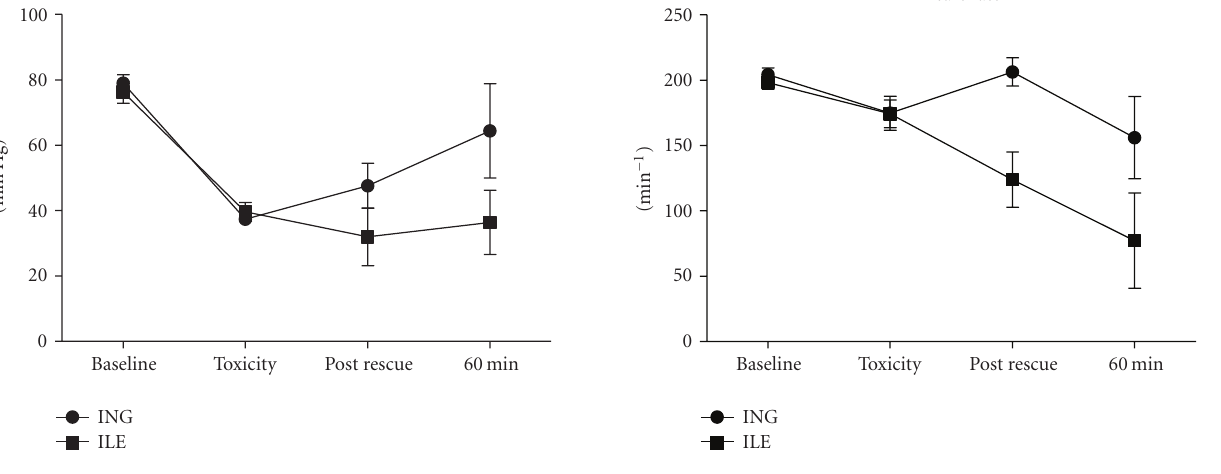
Figure 2: Mean arterial pressure (MAP) versus time. Figure 3: Heart rate versus